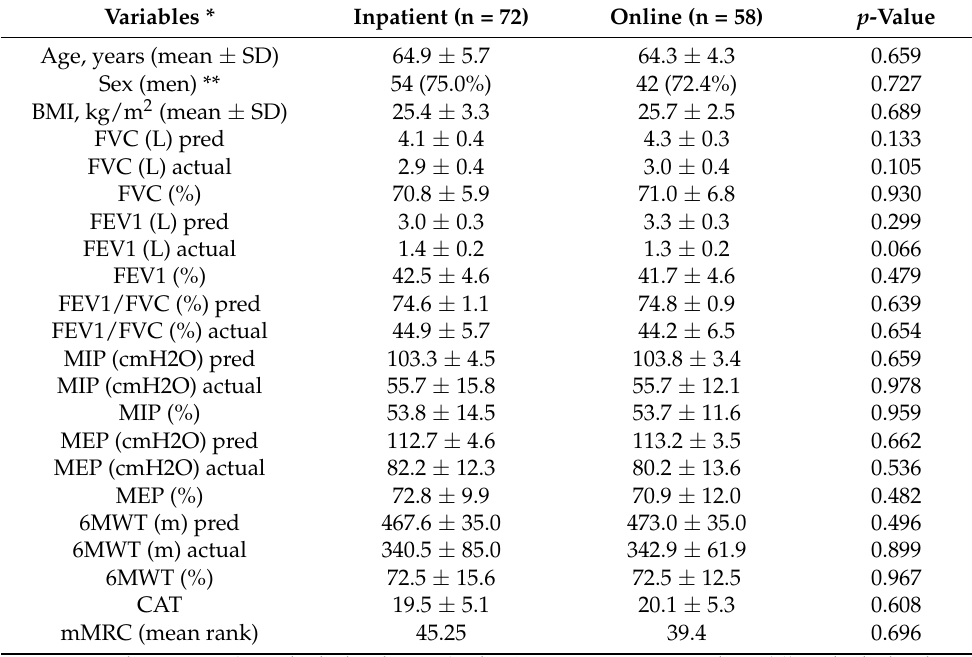
Table 3. Comparison of pre-test results between inpatients and online participants.